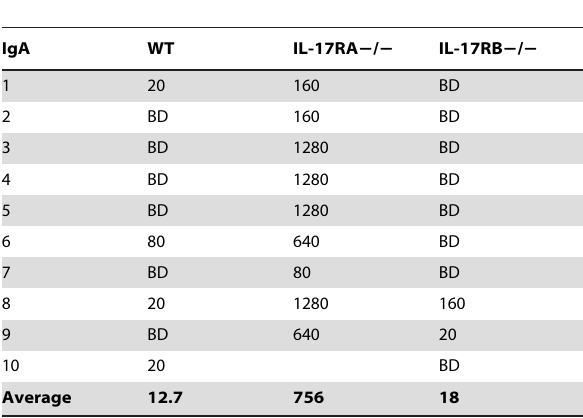
Table 2. H. pylori- specific IgA titers in the serum of H. pylori (strain SS1)-infected mice infected for 3